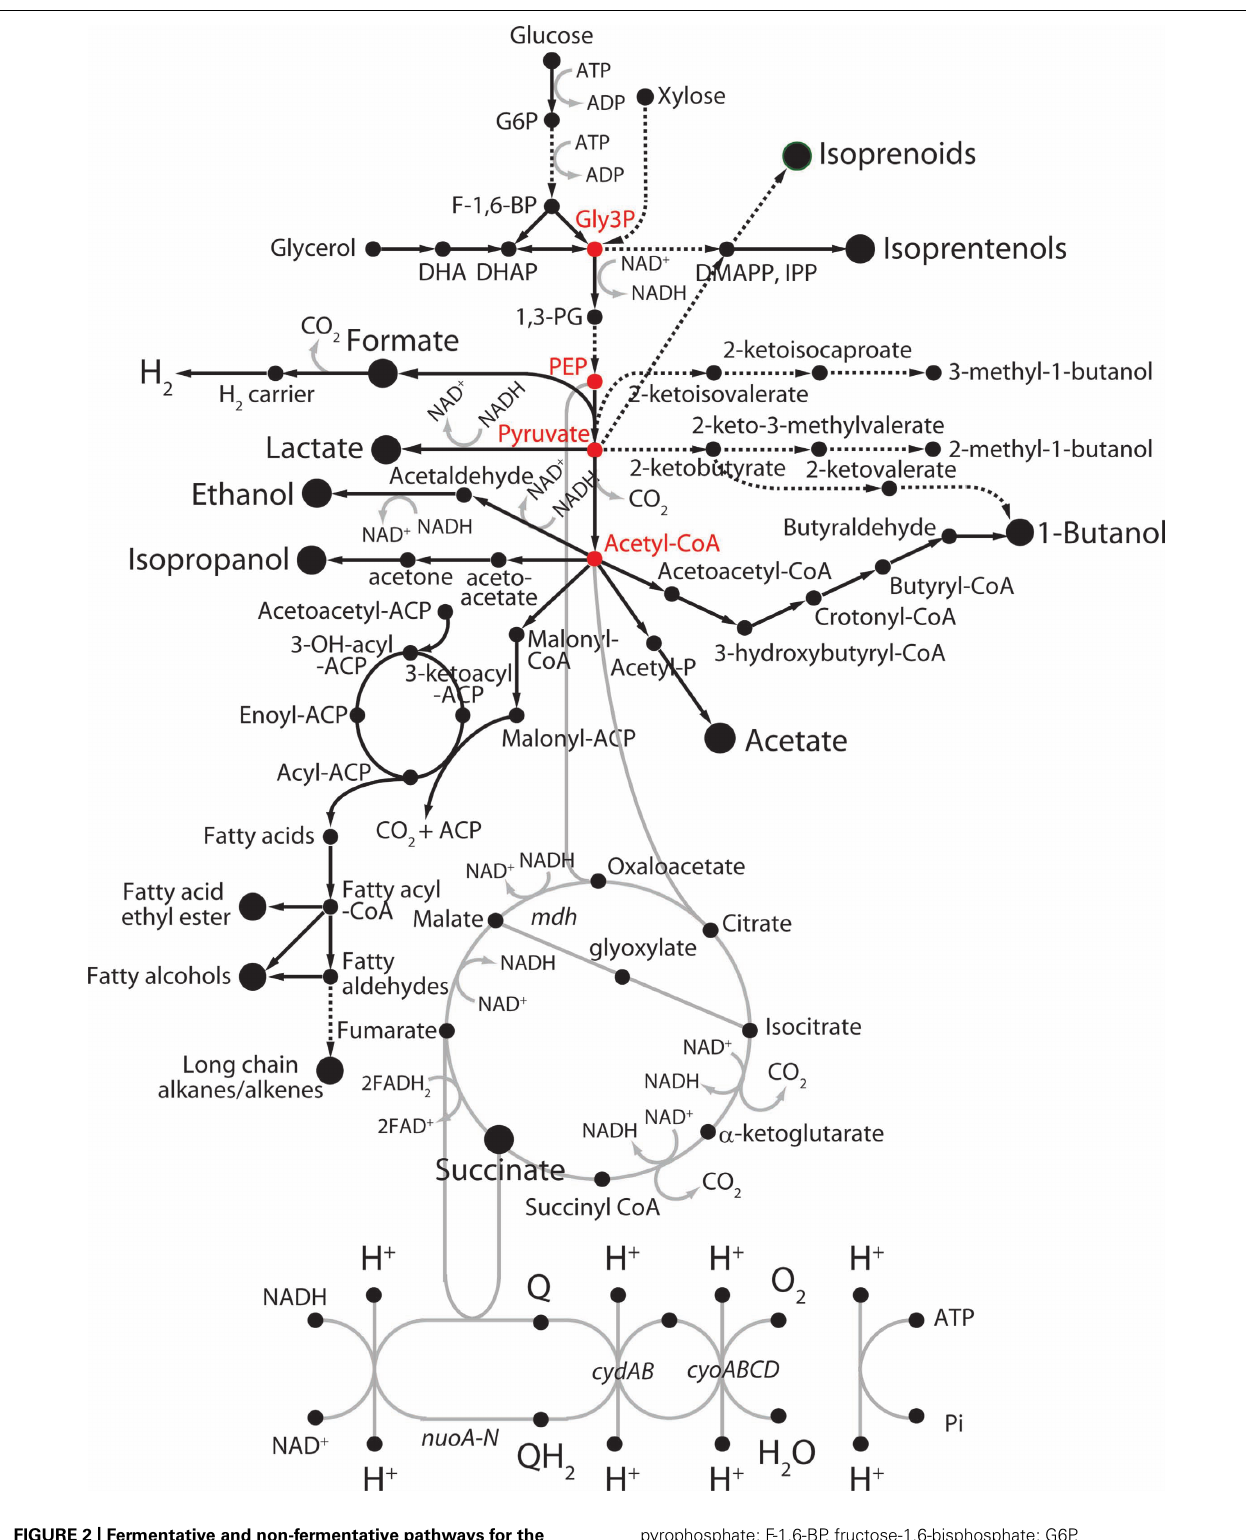
FIGURE 2 | Fermentative and non-fermentative pathways for the production of biofuels in E. coli . Dashed lines represent multiple reaction steps. Red circles represent metabolic intermediates. ACP, acyl-carrier protein; DHAP, dihydroxyacetone phosphate; DMAPP,